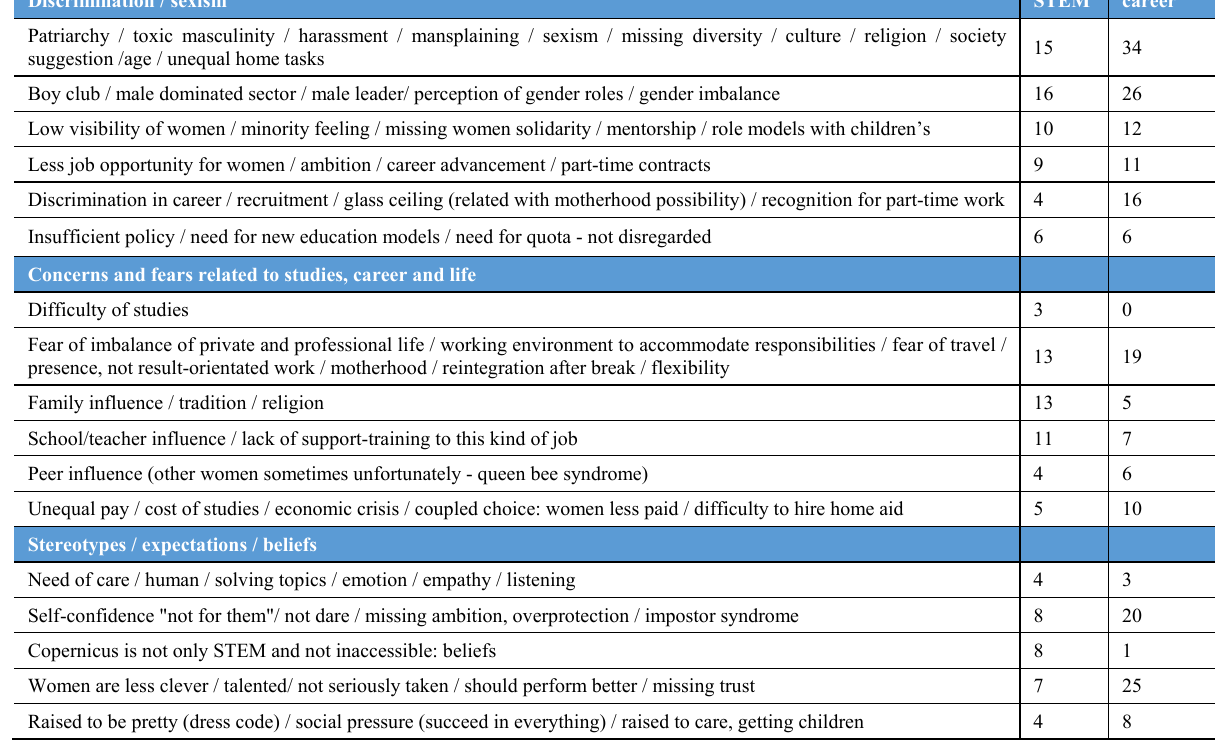
Table 2. Additional barriers mentioned in open